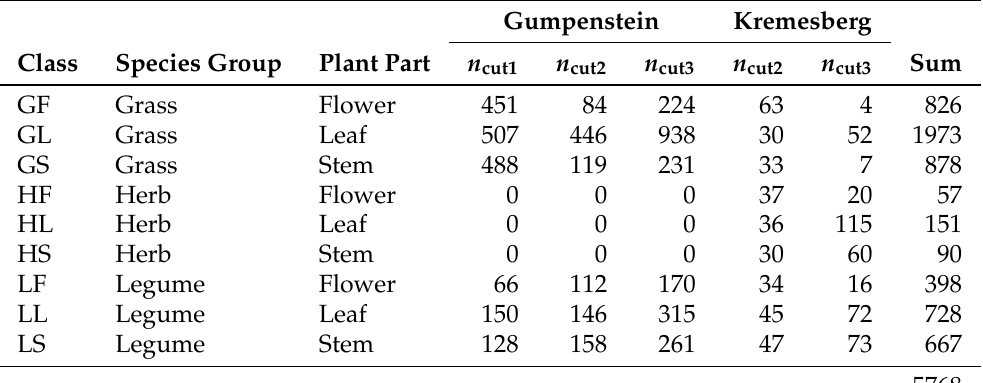
Table 1. Number of samples with regard to class membership, location and seasonal cut. Each plant part (flower, leaf or stem) from a different plant per seasonal cut is considered as a